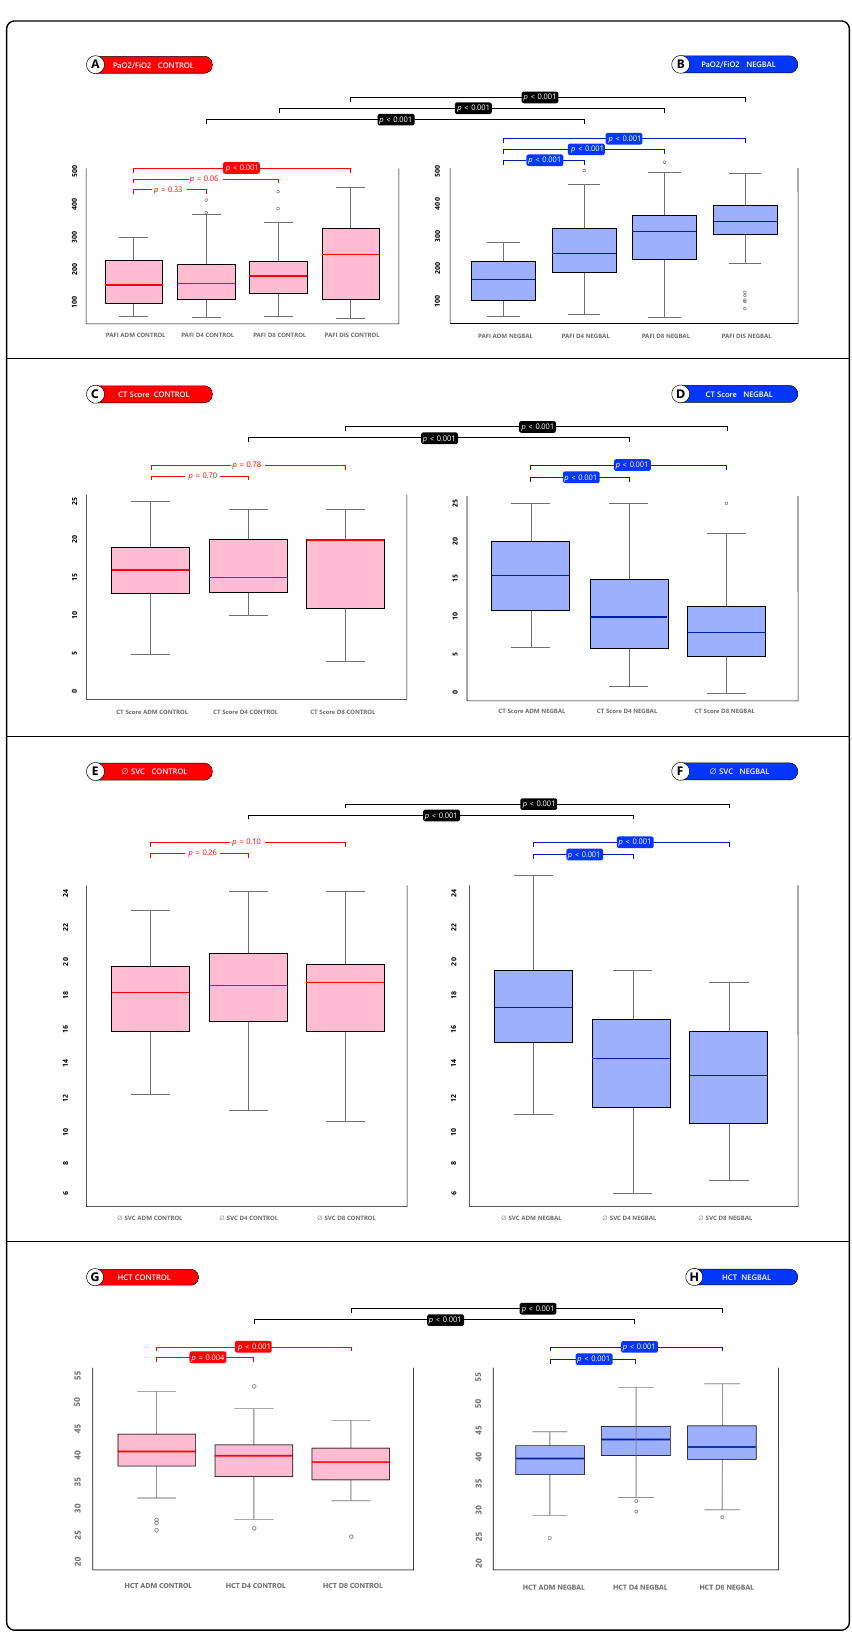
Figure 3. Box plot of comparative analysis of PaO 2 /FiO 2 , CT score, diameter SVC and hemat- ocrit. ( A ) PaO 2 /FiO 2 CONTROL; ( B ) PaO 2 /FiO 2 NEGBAL; ( C ) CT Score CONTROL; ( D ) CT Score NEGBAL; ( E ) Ø SVC CONTROL; ( F ) Ø SVC NEGBAL; ( G ) HCT CONTROL; ( H ) HCT